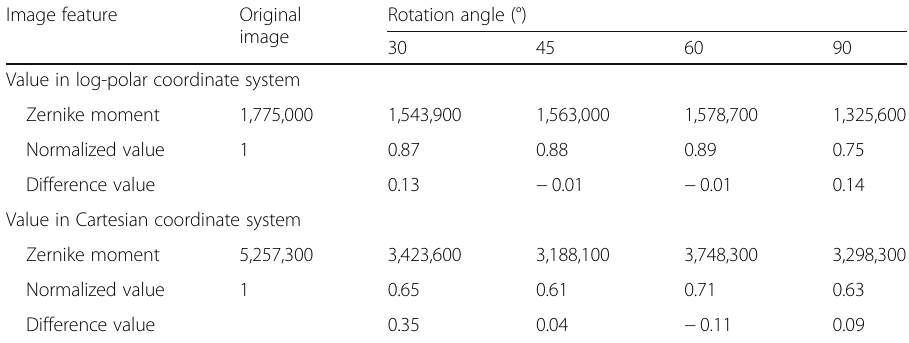
Table 1 Comparison of Zernike moment between the original and rotated images in two coordinates